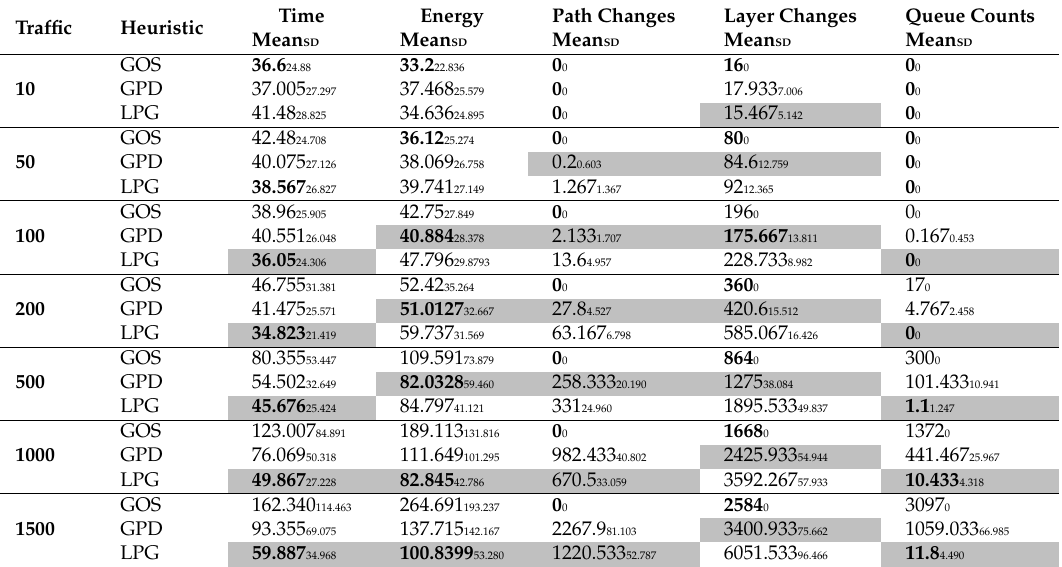
Table 5. Comparison of traffic performance using GOS, GPD and